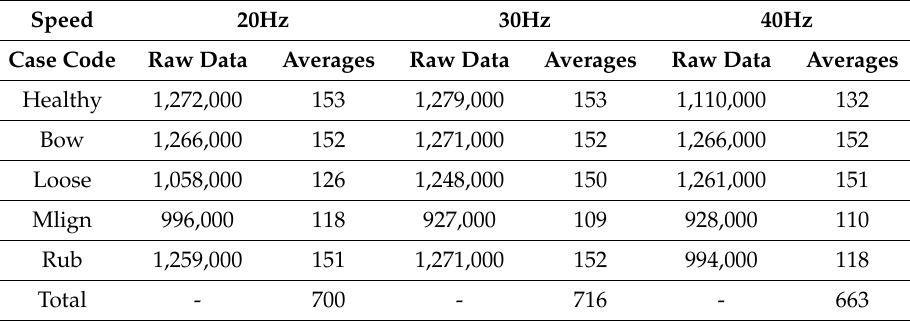
Figure 4. Two-stage overlap method for the preparation of datasets. Table 2. The number of raw data points and averages in each